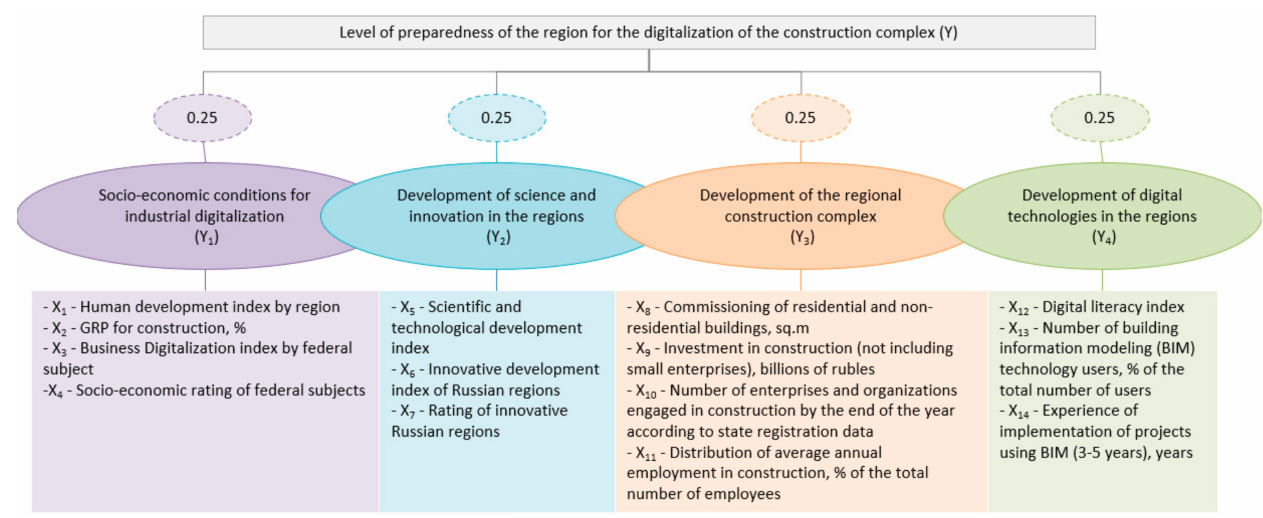
Figure 2. Formation of an aggregate indicator for assessing the level of preparedness of the region for digitalization of the construction